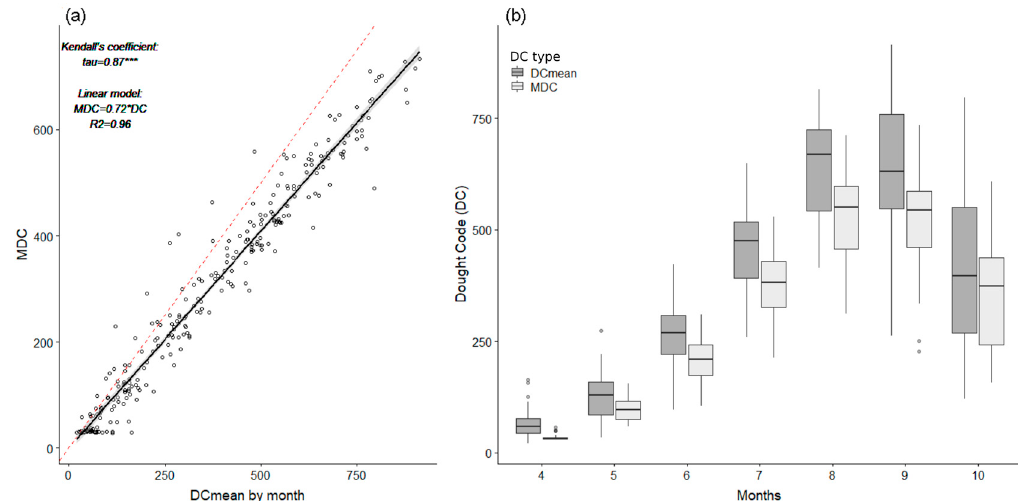
Figure 3. ( a ) Correlation between the Monthly Drought Code (MDC) and DCmean using monthly values from April to October over the 1979–2016 period (n = 532 corresponding to seven months each year for 38 years). The dotted red curve represents the perfect match between DCmean and MDC, while the black curve is the linear regression model found (MDC = aDC + b), and for which the normal distribution and homoscedasticity of residuals were tested.;( b ) DCmean and the MDC changes along the fire-season (currently encompassing months from April to October).